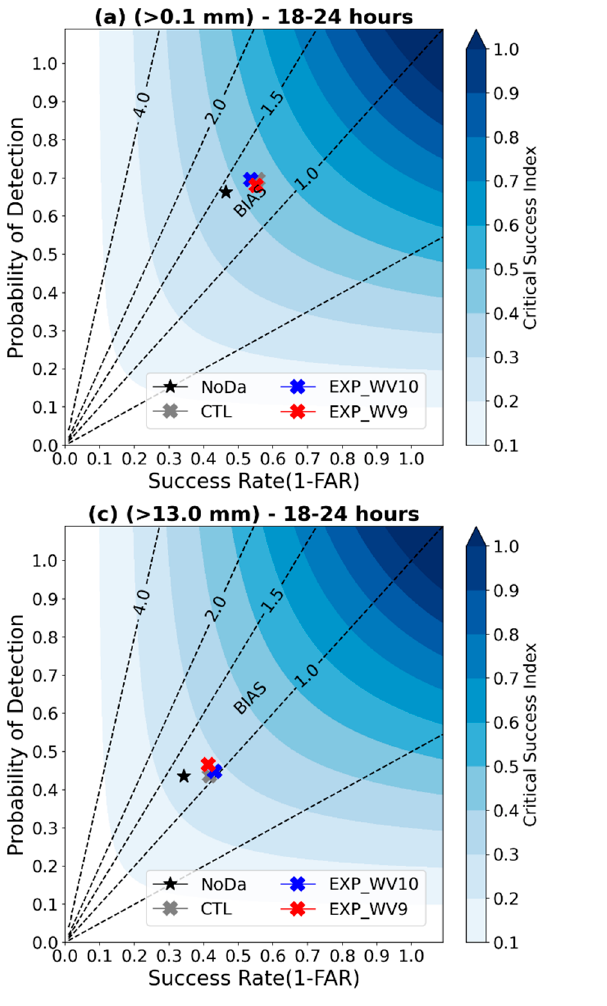
Figure 14. Performance diagram for the 6 h accumulated precipitation for the NoDA (grey), CTL (blue), EXP_WV9 (magenta), and EXP_WV10 (cyan), with a threshold of ( a ) 0.1 mm, ( b ) 4 mm, ( c )